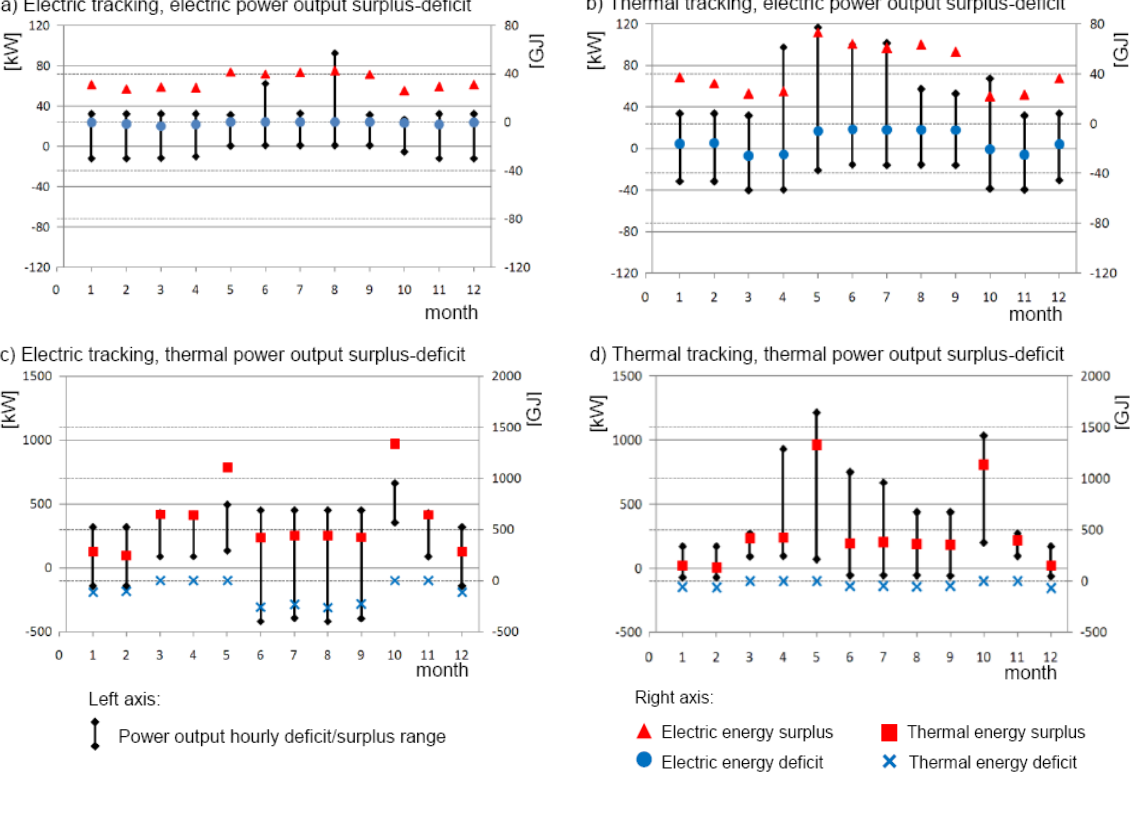
Figure 8. Hotel electric and thermal power surplus/deficit behaviour during a one year period under electric and thermal load tracking conditions.